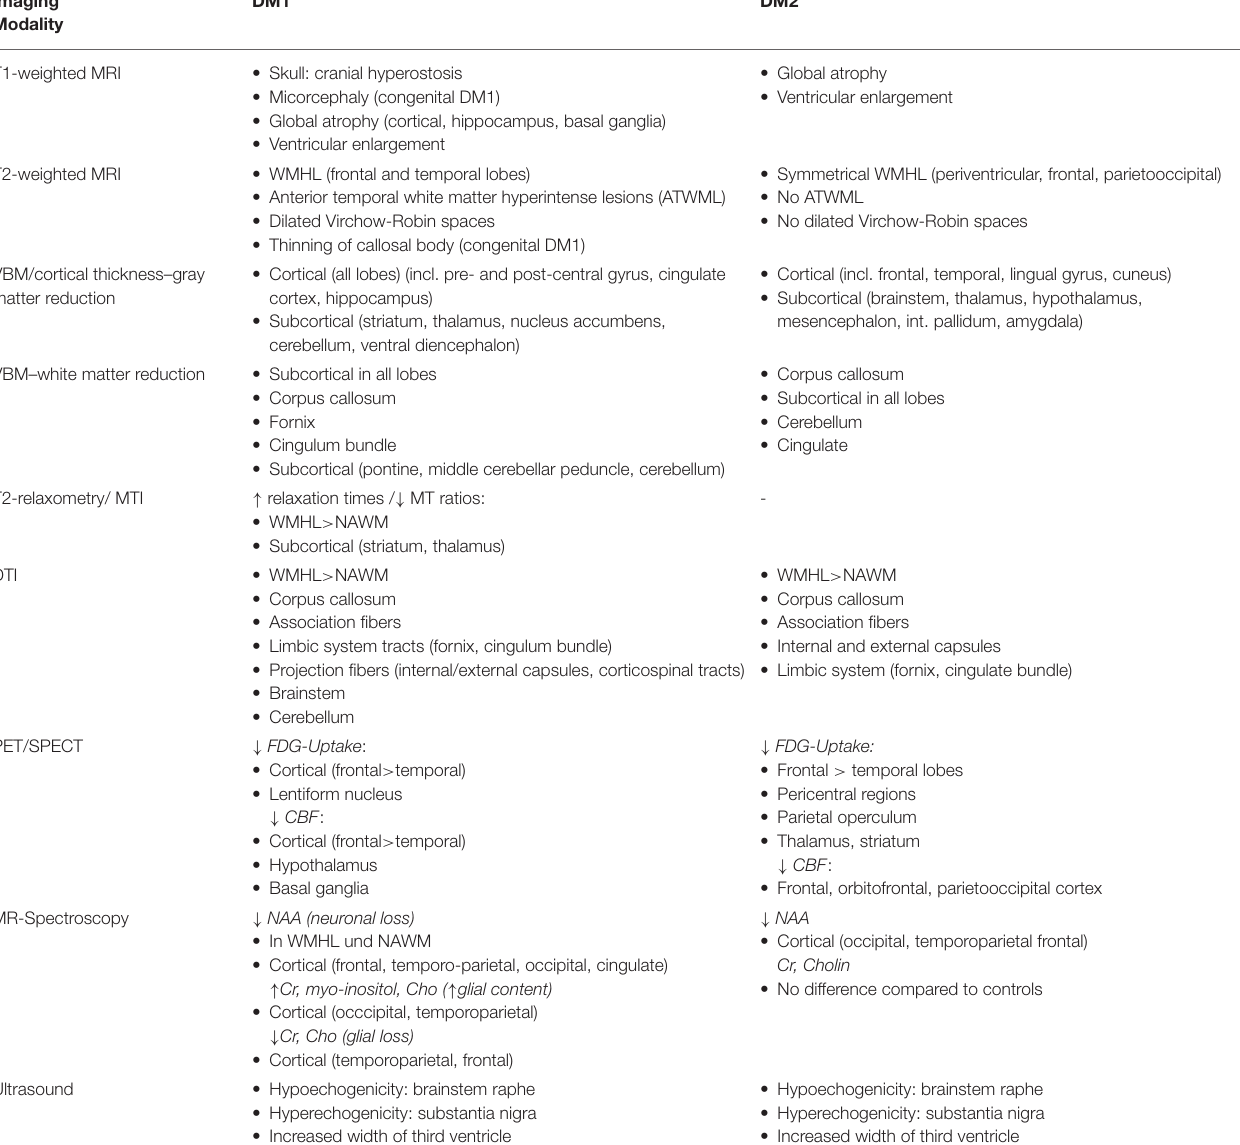
TABLE 9 | Summary of main regional brain changes in DM1 and DM2. Imaging DM1 Modality